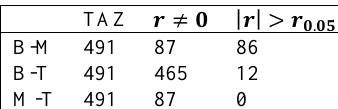
Table 7. The summary of local correlation coefficients